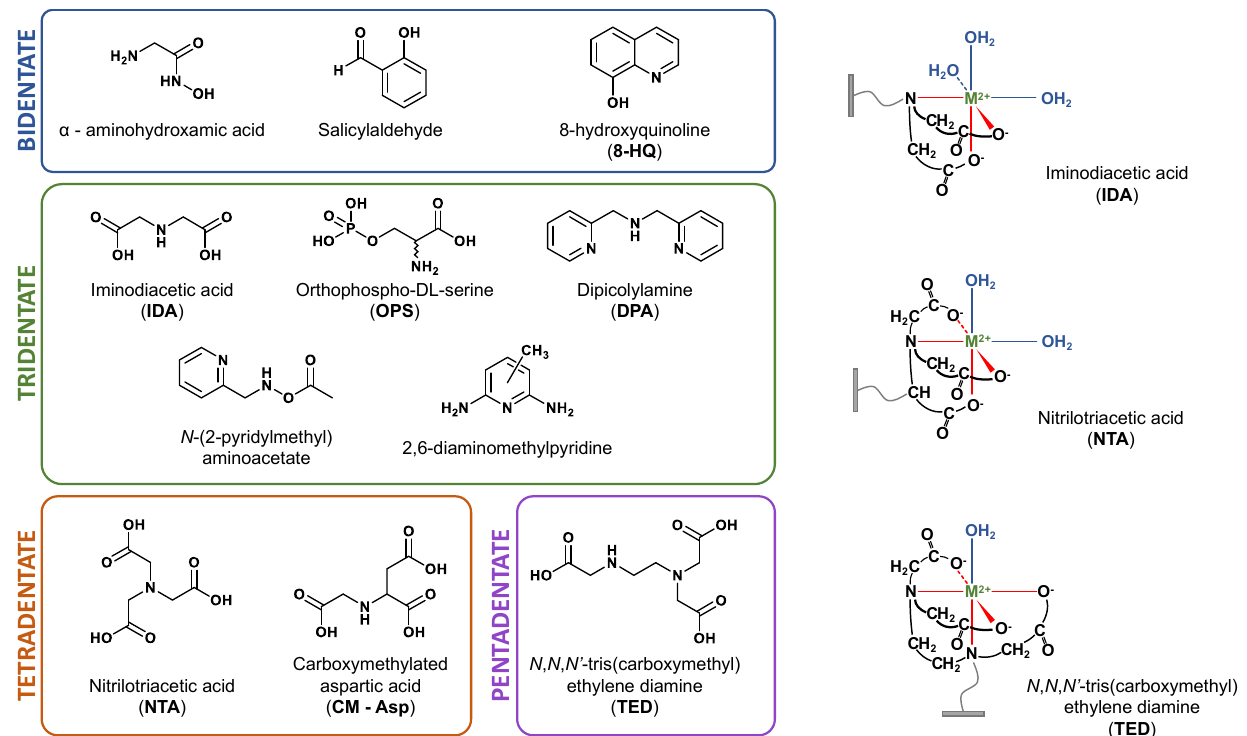
Figure 2. Different complexing agent used in IMAC and representation of the spatial organization of the ligand around the metal ion.